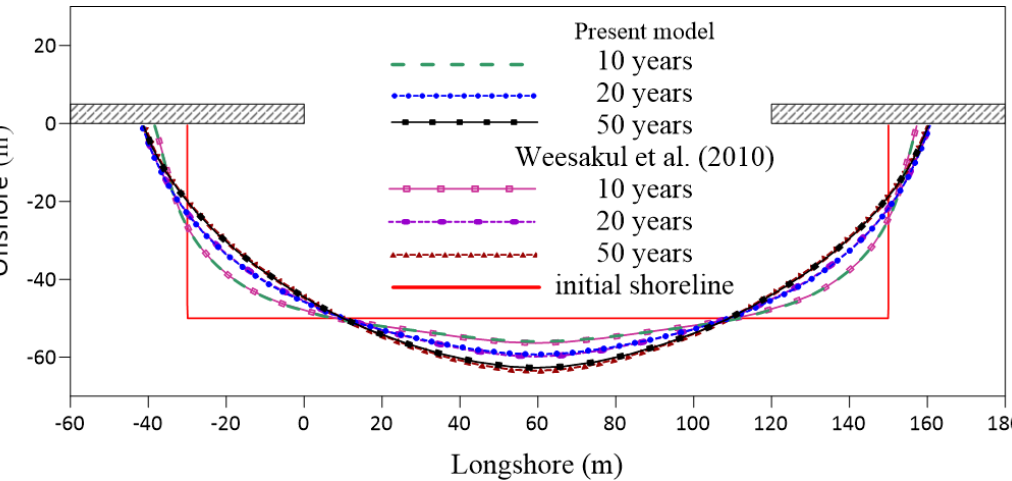
Figure 10. The numerical results and comparisons of shoreline profiles at different time (m = 179, ∆ t = 0.01 s)